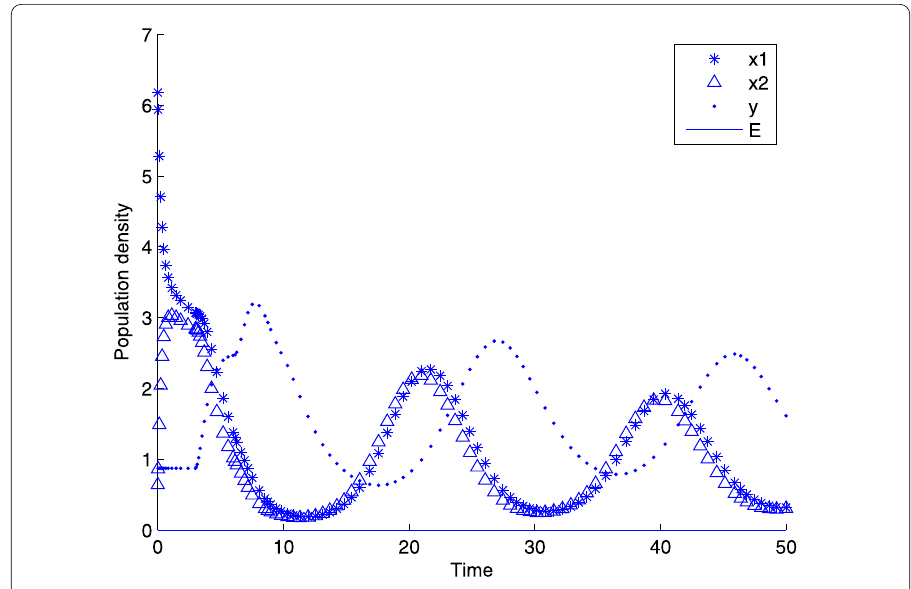
Figure 4 The state response of system (4) with τ = 3 at P 3 . The state response of system (4) with τ = 3 at P 3 .